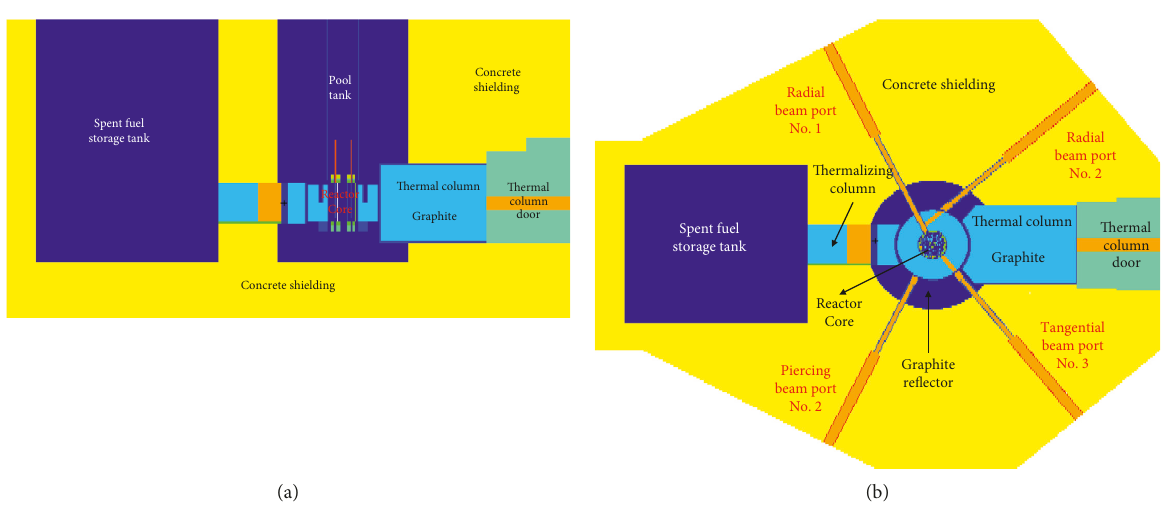
Figure 3: Vertical (a) and horizontal (b) cross sections of the MCNP5 geometry with concrete shielding, four neutron beam tubes, and thermal